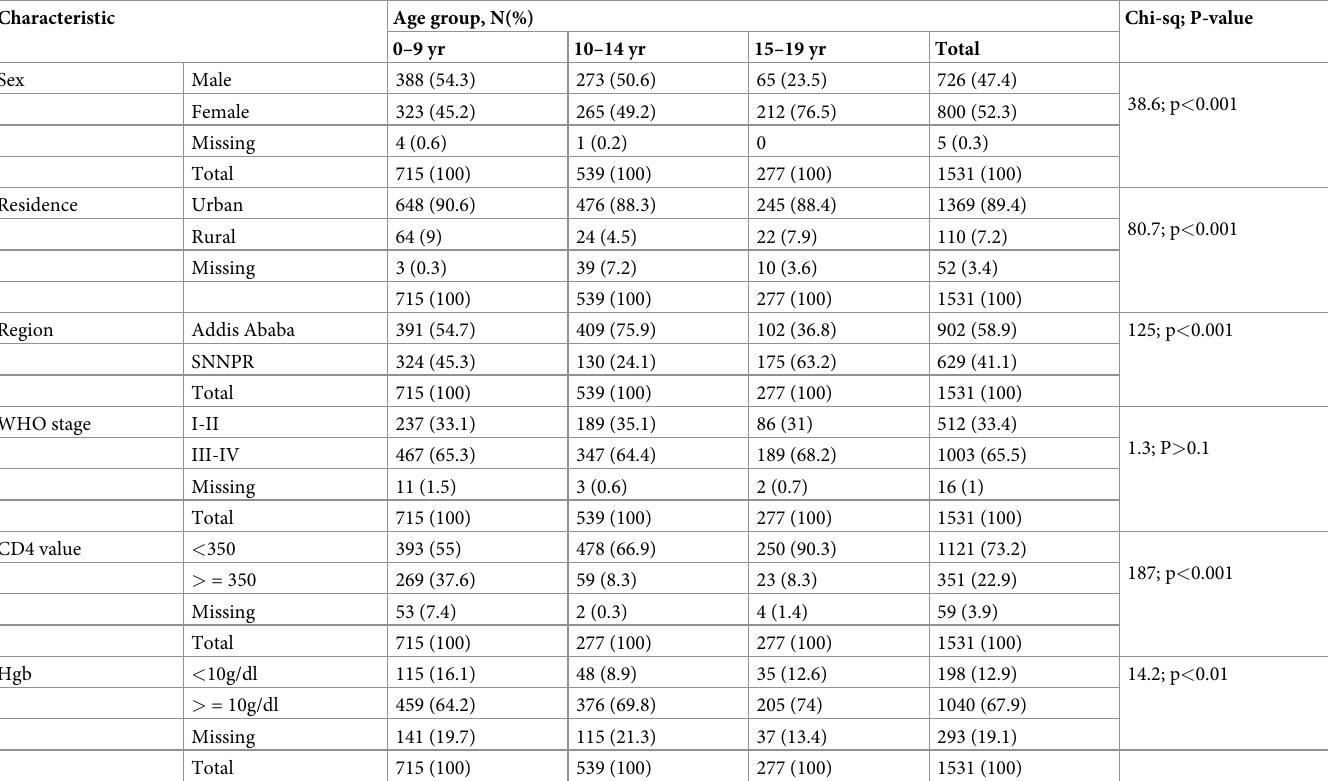
Table 2. Baseline characteristics of patients who were put on